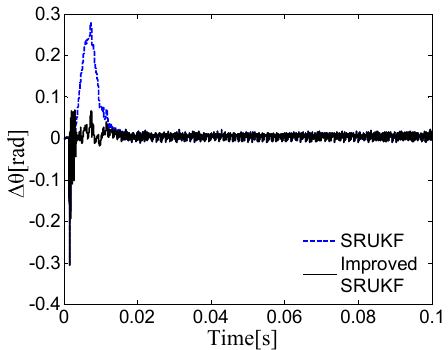
Figure 7. Space position estimation error at 800 rad/s.